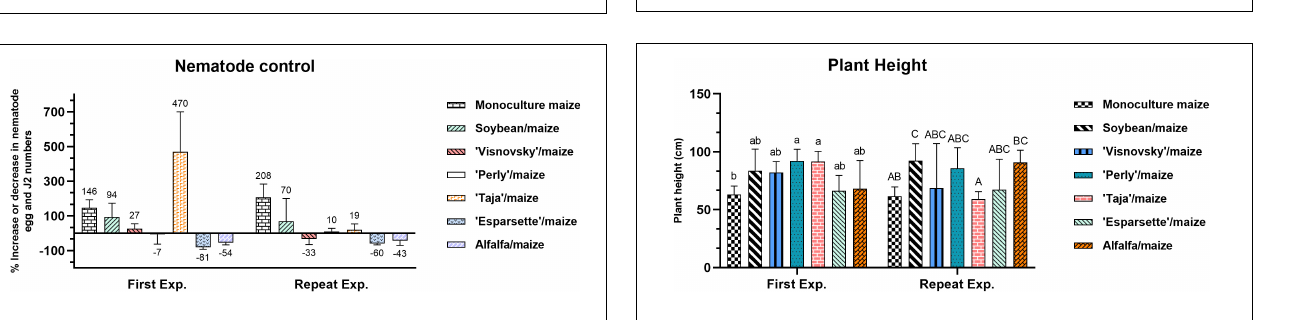
FIGURE 3 | Reproduction factor (Rf) value of a Meloidogyne enterolobii population on maize, 12 weeks post-inoculation with ± 500 eggs and second-stage juveniles, and incorporation of aerial material of maize (P-2432-R), soybean (DM-5953-RSF), sainfoin (Esparsette, Taja, Perly, Visnovsky), and alfalfa (BAR 7) into the soil and rotation thereof. The y -axis shows Rf value. Different letters indicate significant differences at P ≤ 0.05 based on Tukey’s test for each experiment separately.